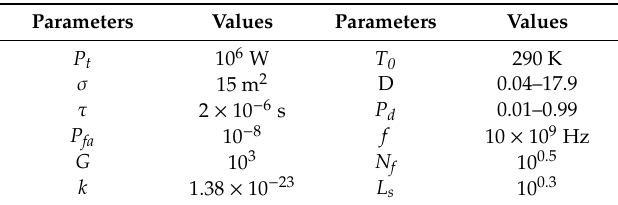
Table 1. Detailed airborne radar parameters and